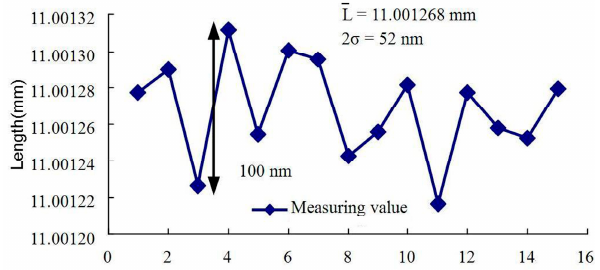
Figure 10. The repeated measuring results of sample gauge block.